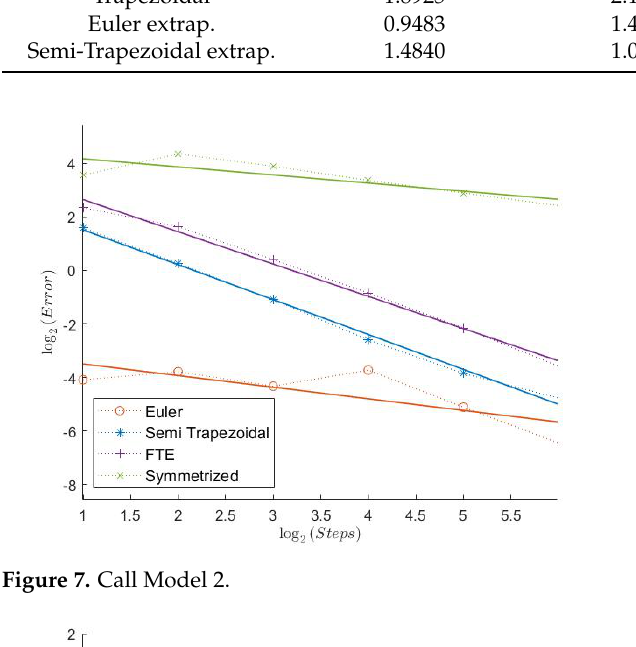
Figure 7. Call Model 2.